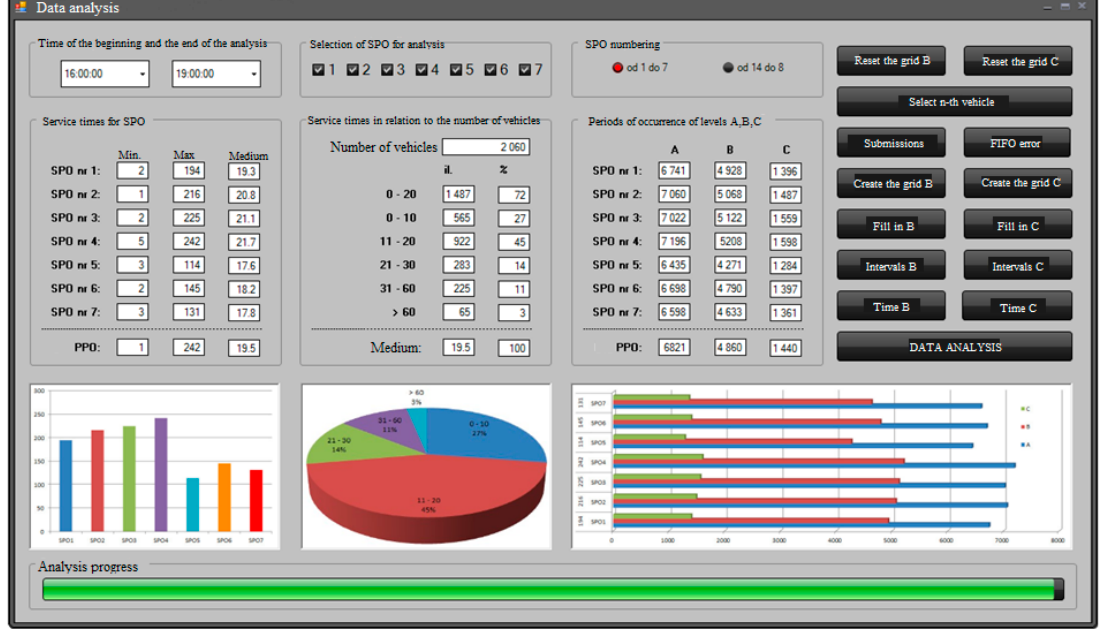
Figure 9. View of the system software while working in the mode of analysis related to the operation of vehicles at the toll collection station and the grouping of these tolls. Source: own study.